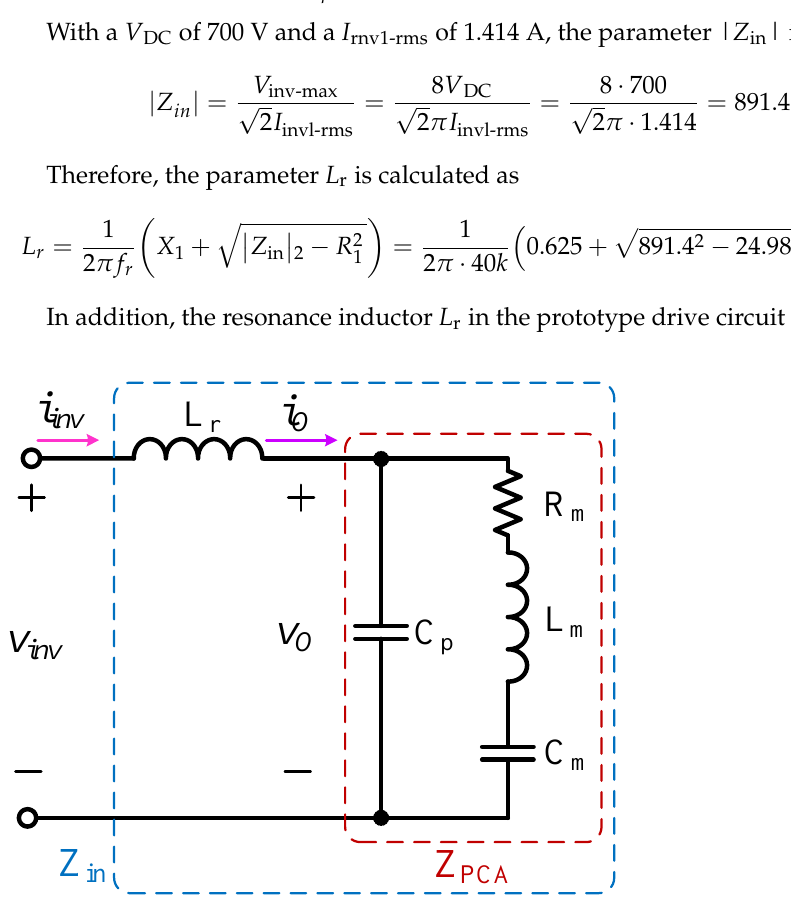
Figure 14. The equivalent circuit diagram of the resonant tank circuit combined with the piezoelectric ceramic actuator circuit model.